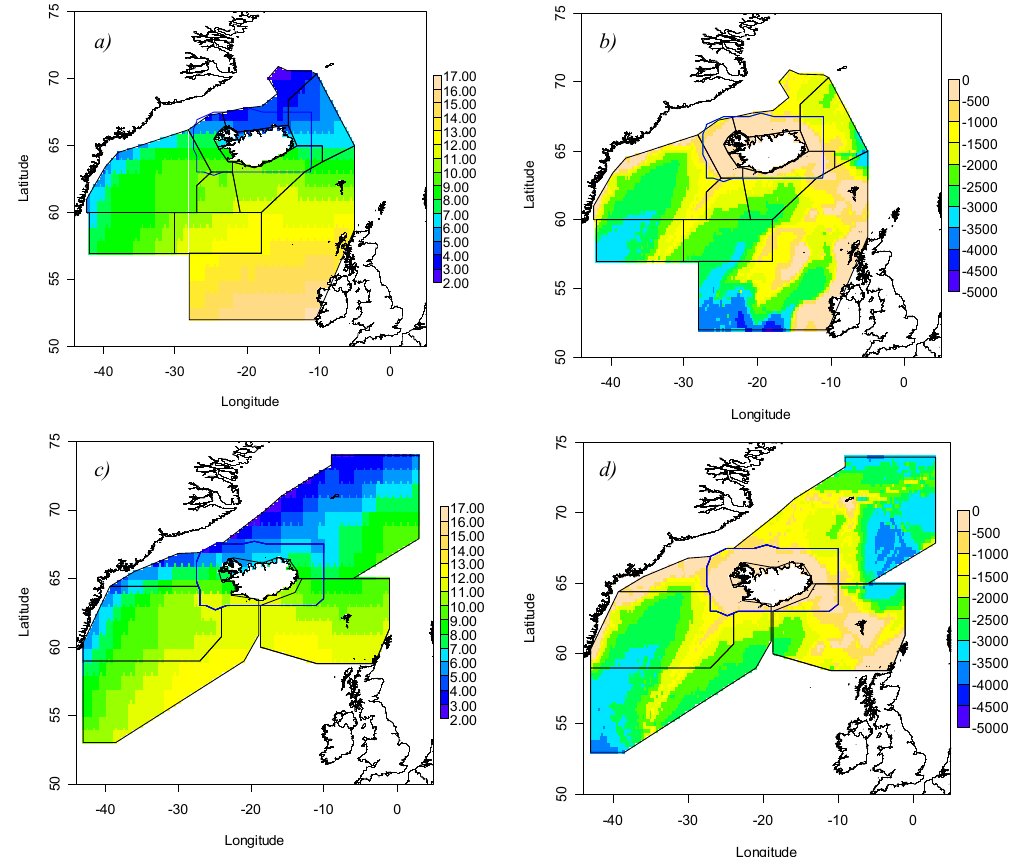
Fig. 3. Environmental covariates used in the analysis. a) mean sea surface temperature (˚Celsius) 18th June– 6th August 1995, b and d) Depth (m) & c) mean sea surface temperature 17th June–5th August 2001. Black lines indicate the ship survey blocks and the blue lines indicate the aerial survey